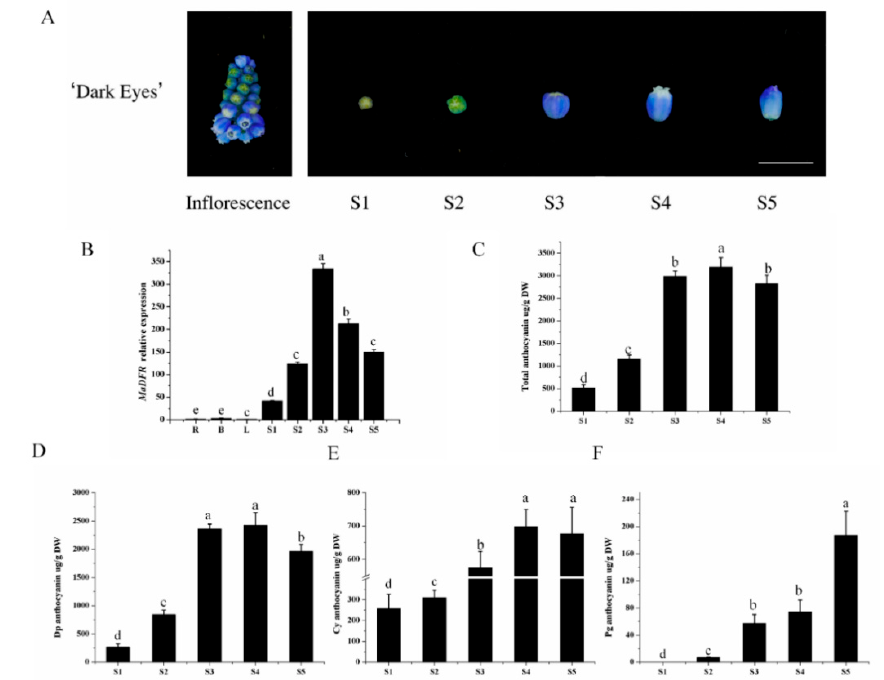
Figure 2. Anthocyanin content and MaDFR expression profiles in grape hyacinth. ( A ) The inflorescence and petals at five developmental stages. Flower development is divided into five stages: S1, newly formed flower buds with a little color; S2, development of petals with some color; S3, completely colored but closed petals; S4, completely colored and open petals; S5, flower senescence. Scale bars = 5 mm. ( B ) The expression profile of MaDFR , MaDFR expression in roots (R), bulbs (B), leaves (L) and flowers at five developmental stages. ( C ). Accumulation of total anthocyanins at five developmental stages in grape hyacinth. ( D ). Accumulation of delphinidin (Dp) at five developmental stages in grape hyacinth. ( E ). Accumulation of cyaniding (Cy) at five developmental stages in grape hyacinth. ( F ). Accumulation of pelargonidin Pg at five developmental stages in grape hyacinth. DW: Dry weight. Data represent the means ± SEs of three independent experiments.